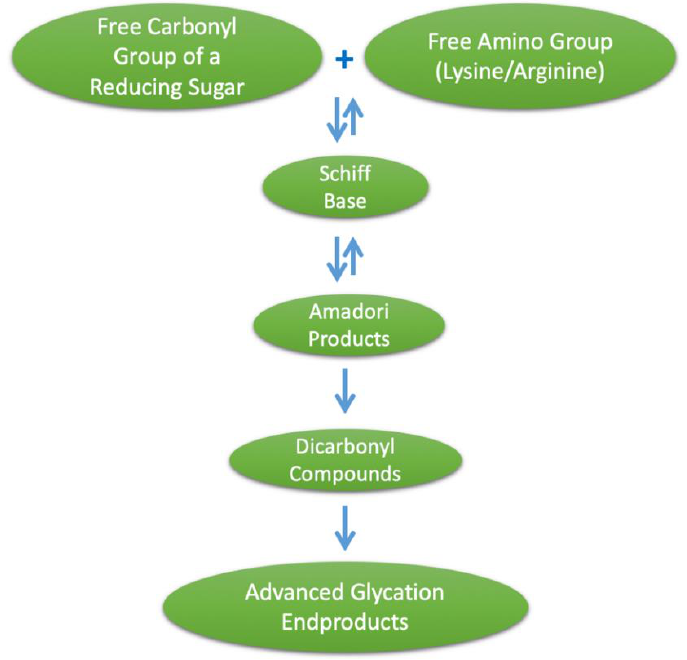
Figure 1. Formation of advanced glycation end products (AGEs).